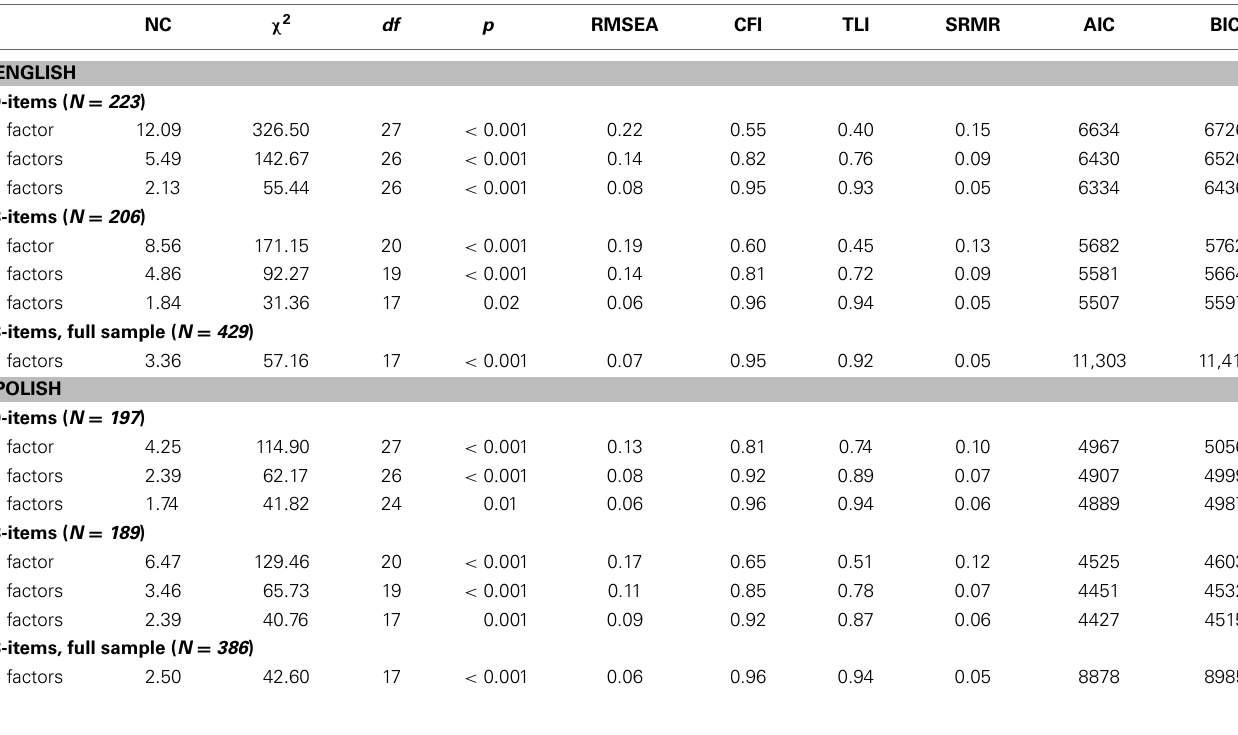
Table 1 | The confirmatory factor analyses using maximum likelihood estimation with robust standard errors